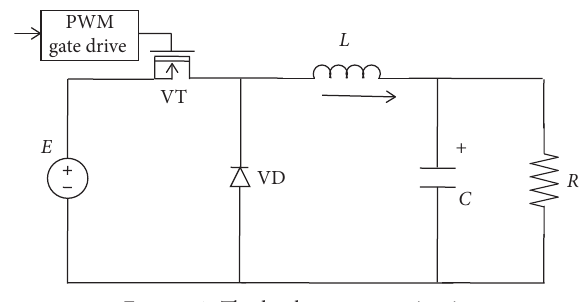
Figure 1: The buck converter circuit.